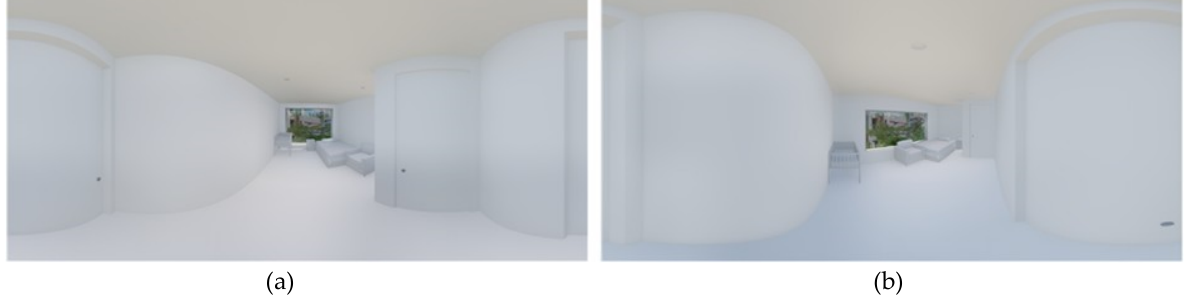
Figure 2. VR space 360 ◦ 3D image example. ( a ) It is an image with 2.3 m of ceiling height and 80% of window area ratio applied to the aspect ratio A type of space. ( b ) It is an image with 2.3 m of ceiling height and 60% of window area ratio applied to the aspect ratio of the space B type.